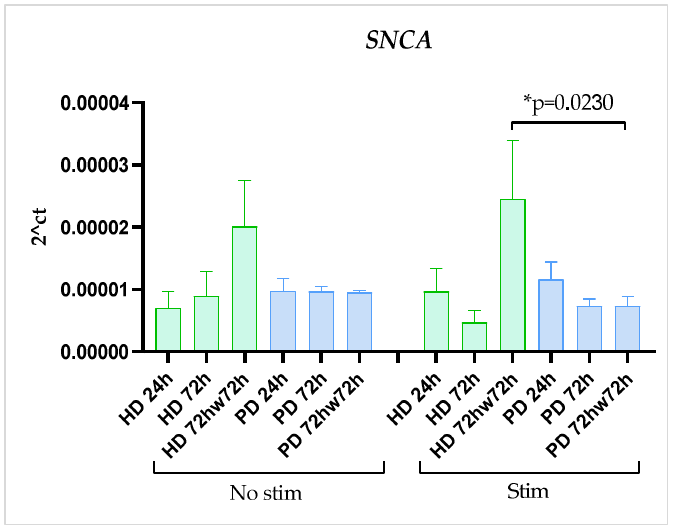
Figure 5. SNCA expression in glial cultures derived from iPSCs of HD and patients with PARK2 - associated PD in steady state and under inflammatory conditions at different time points of cultivation. Green columns correspond to HD glial cultures, blue—to PD glial cultures. Gene expression was estimated using qPCR (n = 3). The data are shown as mean ± SEM. Two-way ANOVA with multiple comparisons corrected with Bonferroni test was used for statistical processing. * p <